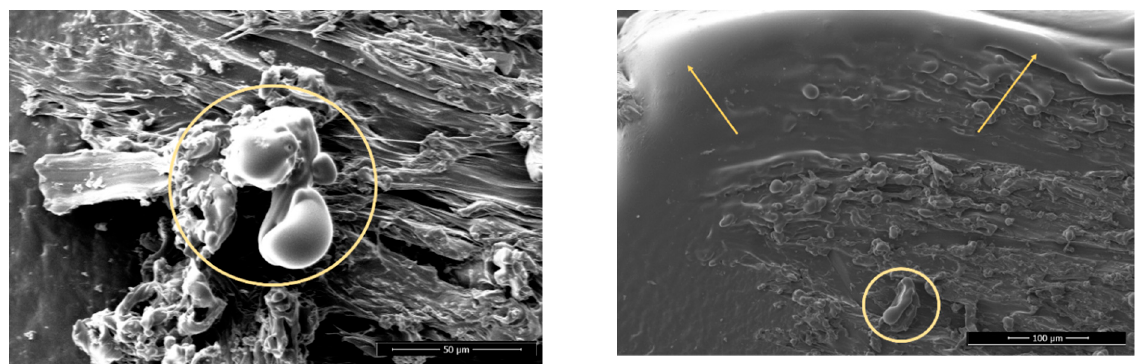
Figure 4. PLA, sanded, plasma treated, 1000 × magnification. Melted particles are encircled, arrows are pointing the melted material edges with rounded appearance.